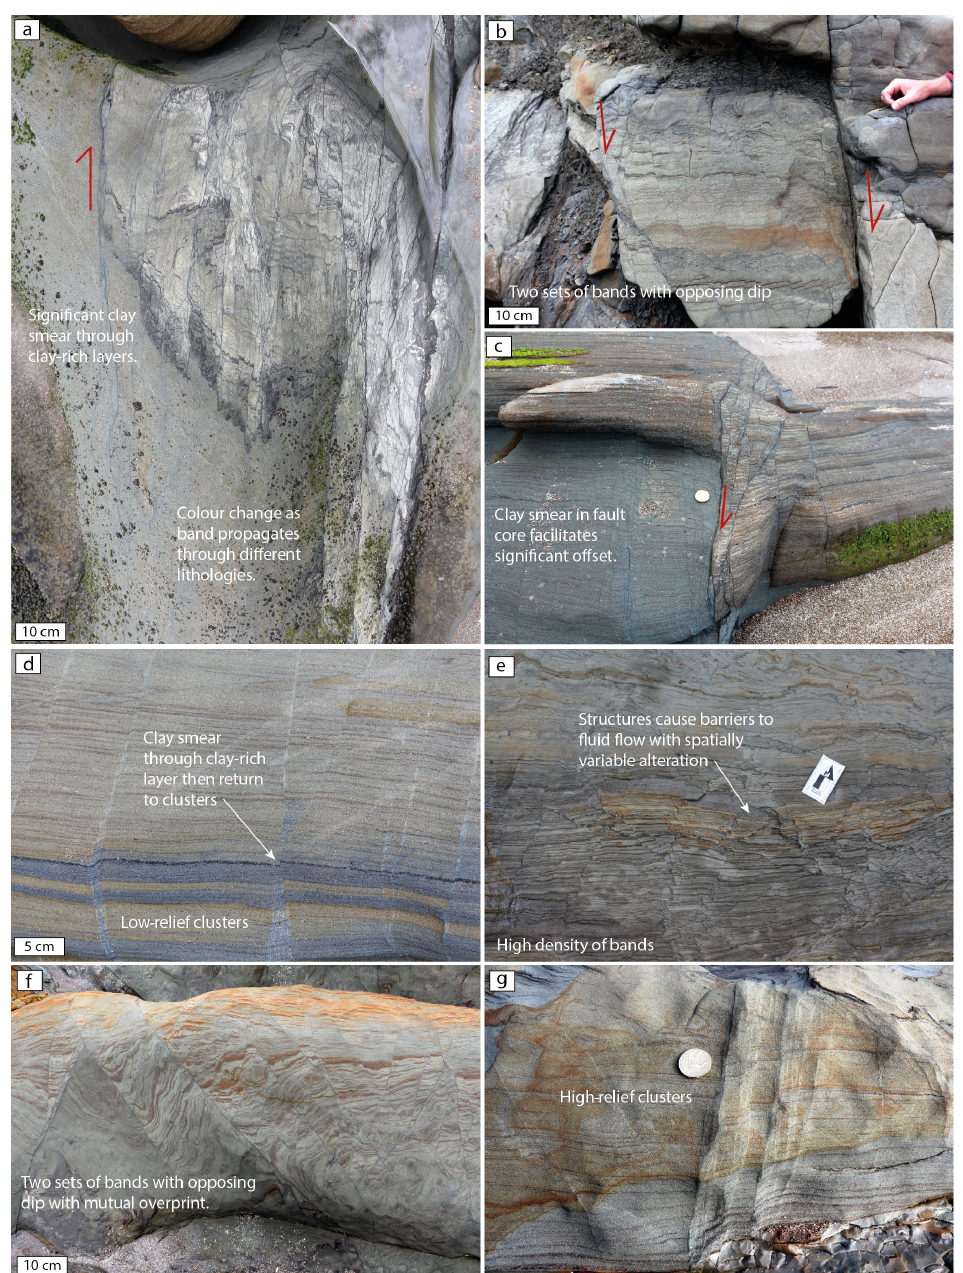
Figure 7. Outcrop images of faults and deformation bands associated with normal faulting. (a) High density of normal-sense shear bands characterised by several centimetres of offset. The bands are hosted in the damage zone of a fault with > 10m offset. Offset cannot be constrained due to exposure conditions. The bands change colour as they propagate through different parts of the host rock with bands towards the top of the image characterised by darker colours after passing through clay-rich layers. To the left of the image, a slip surface (red arrow) removes the clay-rich layer from the image plane. (b) An interaction damage zone between two normal faults. Deformation bands within the damage zone have low relief and a darker colour than the host rock, indicating clay incorporation into the band. (c) Normal- fault plane with a damage zone comprising many deformation bands that are darker in colour than the host rock and exhibit negative relief. (d) Lighter-coloured normal-sense shear bands characterised by low relief. As a cluster propagates through a clay-rich layer, it reduces in width to a single surface. (e) High density of normal-sense shear bands causing the host rock to be significantly compartmentalised. This is supported by the variable colour of the host rock, indicating that later fluid flow is localised and restricted. (f) A dense array of two sets of normal-sense shear bands. All examples cut S 0 and, thus, allow shear-sense determination. (g) Cluster of normal-sense compactional shear bands characterised by high relief and < 1cm